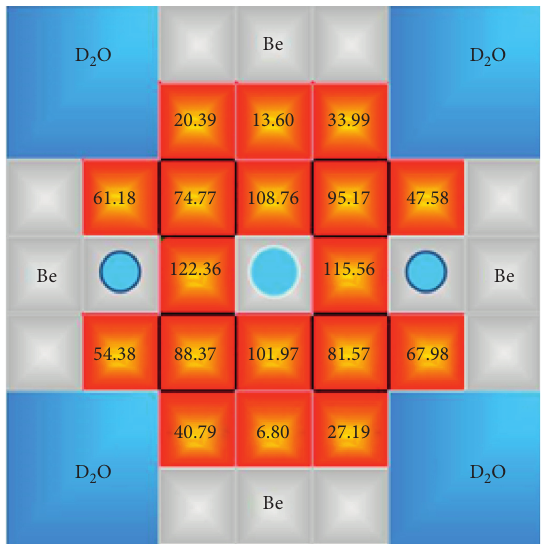
Figure 3: Fuel burnup (MWD/Kg) of each assembly at the end of cycle of a fully burned up